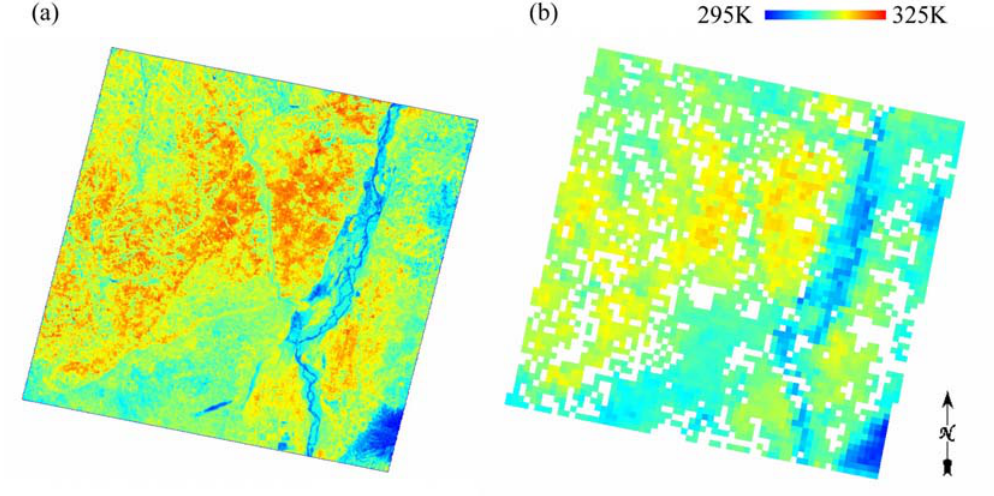
Figure 2 . (a) The ASTER LST image and (b) MODIS image for the study area, dated on 8 June